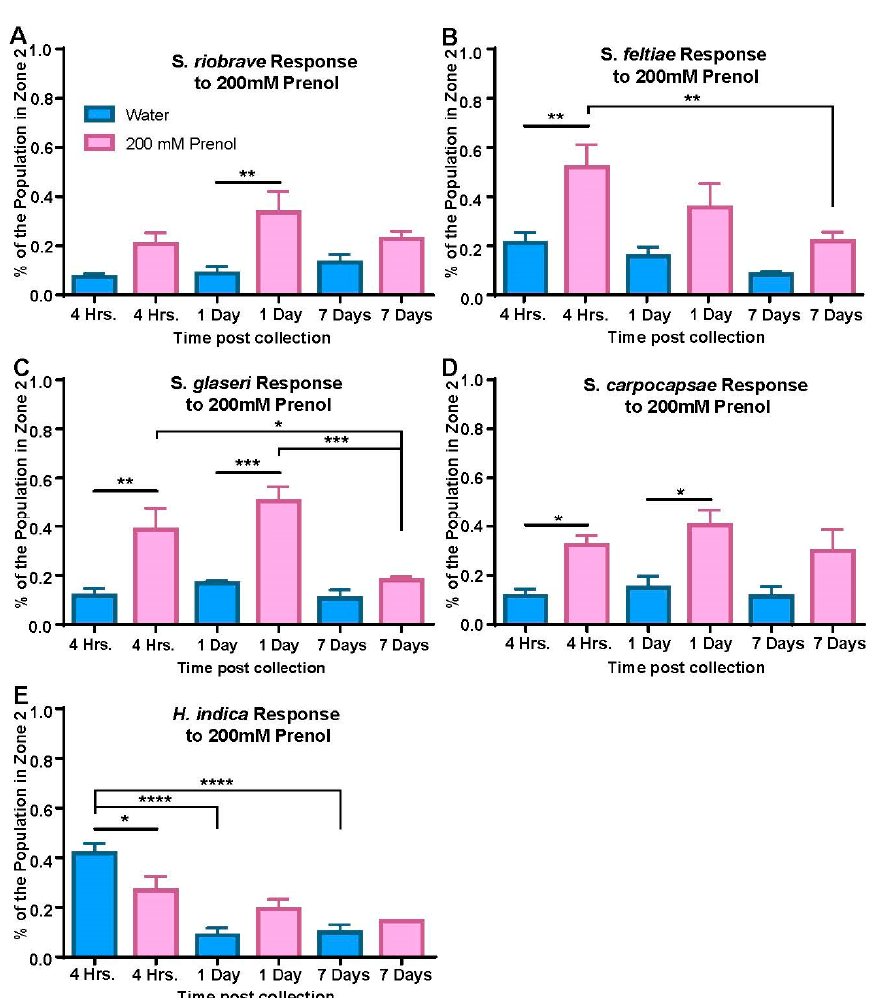
Figure 4. Dispersal assay results for different species of EPNs. Responses to water are shown in blue and responses to prenol (200 mM) are shown in pink. Assays were run for a different length of time for each species ( S. riobrave , S. feltiae , and H. indica were run for 15 min, S. glaseri was run for 10 min and S. carpocapsae was run for 1 h). After the elapsed time, assays were scored to evaluate what percentage of the population had moved completely into zone 2 (see Figure 3A for breakdown of scoring regions). Statistical analysis used two methods: the first was a comparison between water and prenol, done using an RM two-way ANOVA with Sidack’s multiple comparisons test , results shown as a simple bar above prenol and water. A second statistical analysis (using the same parameters as listed above) was used to compare the general responses to prenol over the different time points post- collection.